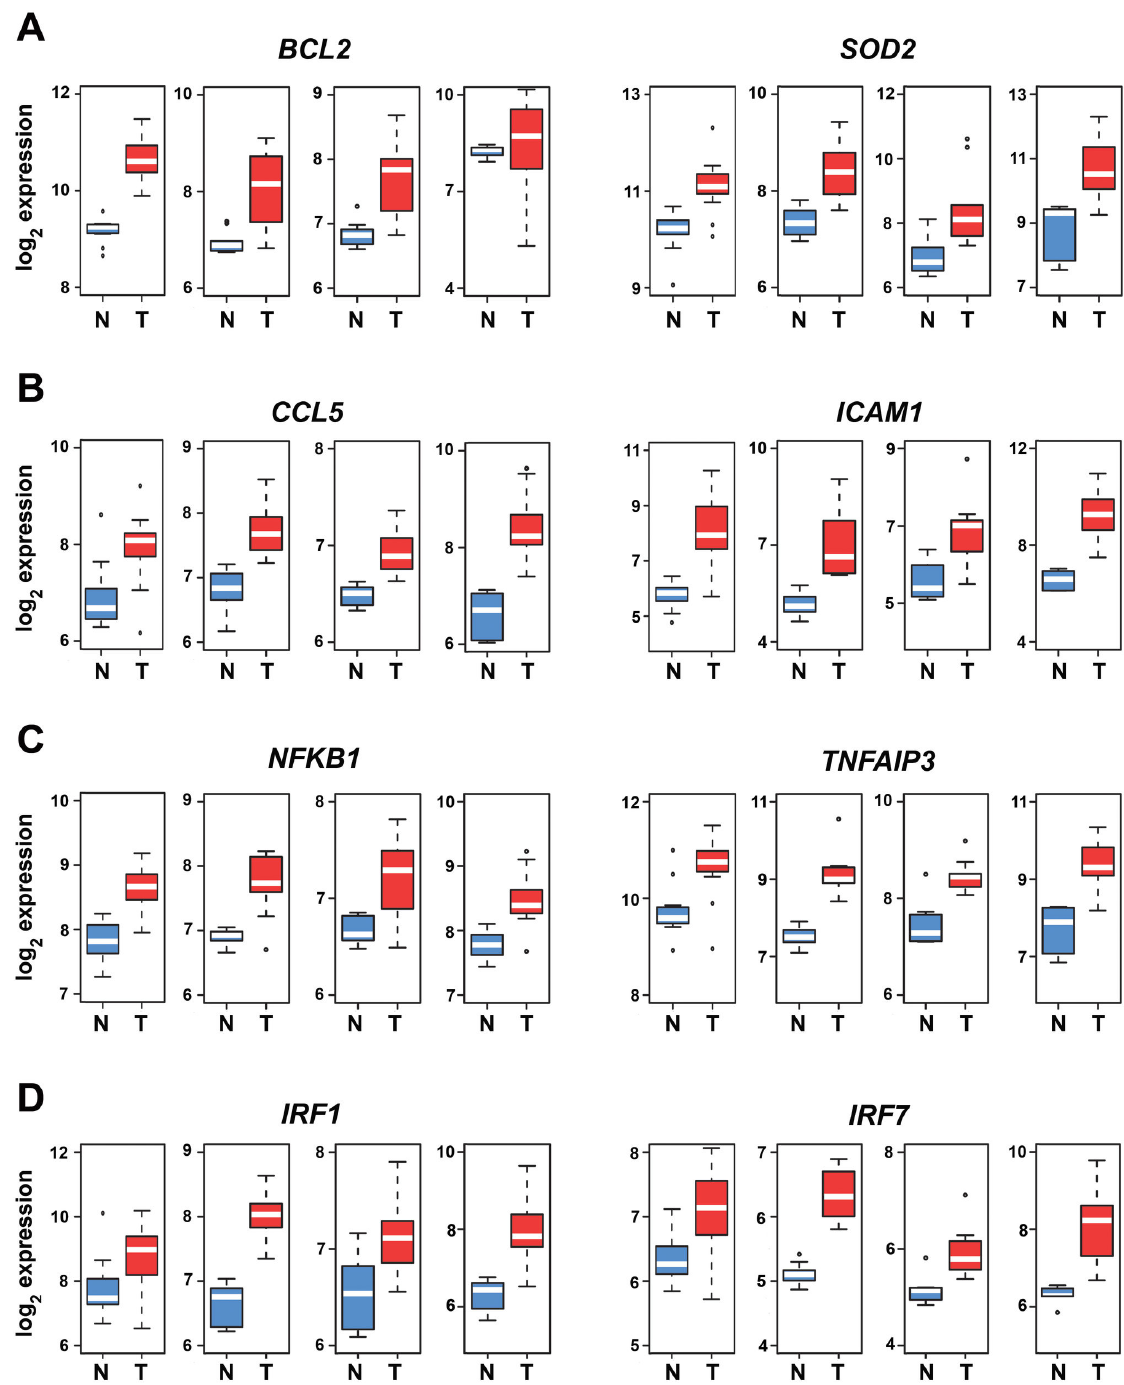
Figure 2. Box plots depicting individual mRNA expression levels of representative genes from the NF-κB signature. (a) Cell-survival genes BCL2 and SOD2 , (b) pro-inflammatory genes CCL5 and ICAM1 , (c) NF-κB regulators NFKB1 and TNFAIP3 and (d) interferon regulatory factors IRF1 and IRF7 . Data were normalized using RMA. Fold-changes for Tumor (T) versus Normal (N) comparison were obtained by LIMMA. Y-axis shows RMA-normalized expression level (on log represent gene expression levels in normal tissue, and red depicts expression in ccRCC. The white line within each box is the median, and distance between box and whiskers indicate interquartile ranges. Each of the four graphs per gene represent expression profiles in arrays generated by (from left to right) the Cifola, Gumz, Lenburg, and Yusenko studies. doi: 10.1371/journal.pone.0076746.g002 PLOS ONE |